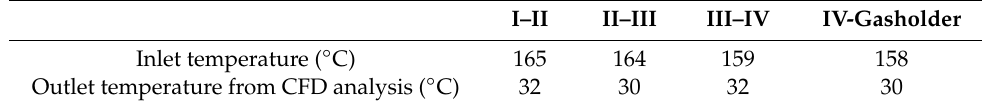
Table 11. Results of the heat transfer analysis for the spiral cooling